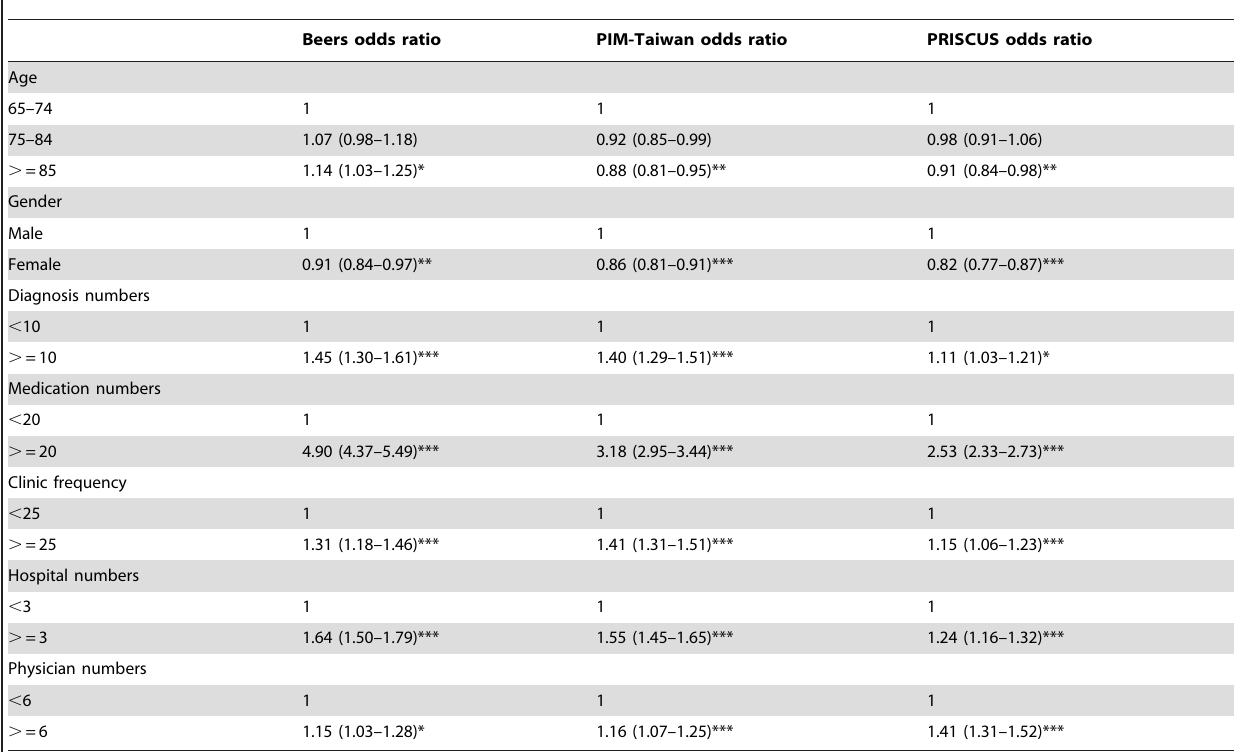
Table 4. Multivariate logistic regression for having at least one drug as potentially